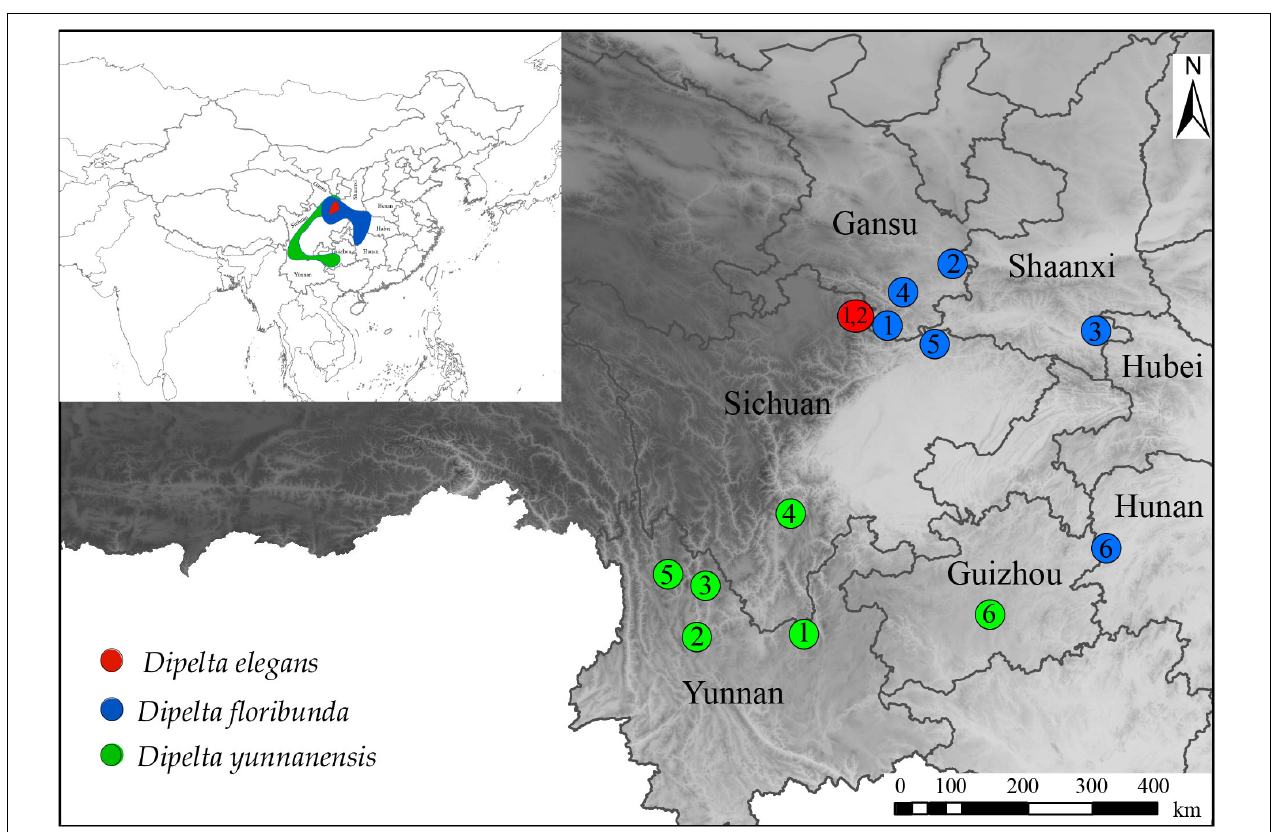
FIGURE 1 | Geographical distribution and sampling locations of Dipelta